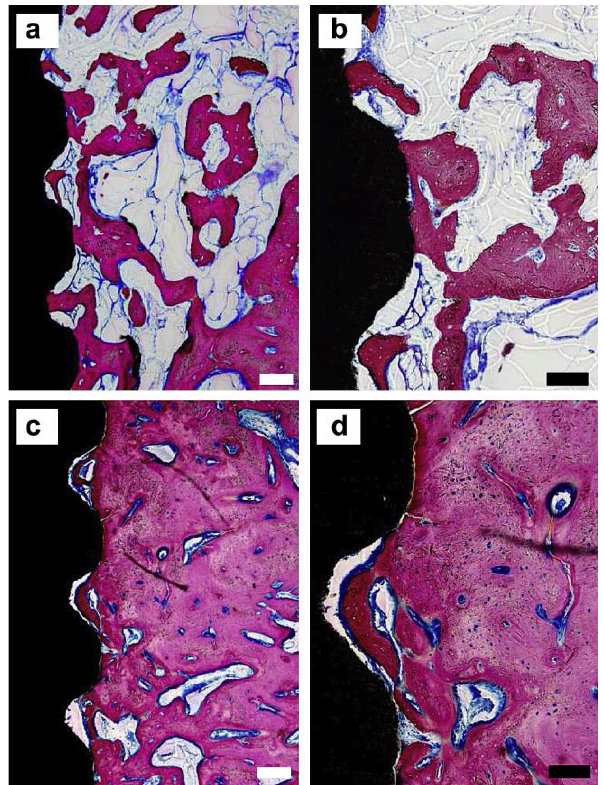
Figure 2. Histological analysis of th e tissue response to bare polyetheretherketone (PEEK) ( a , b ) and fluorine doped hydroxyapatite (F-HA)/PEEK implants ( c , d ) after 8 weeks. The subfigures ( b ) and ( d ) refer to the higher-magnification images of ( a , c ). The dark red area represents the newly formed bone, and dark black represents the PEEK-based implant. (white scale bar: 200 μm, black scale bar:100 μm) [73].